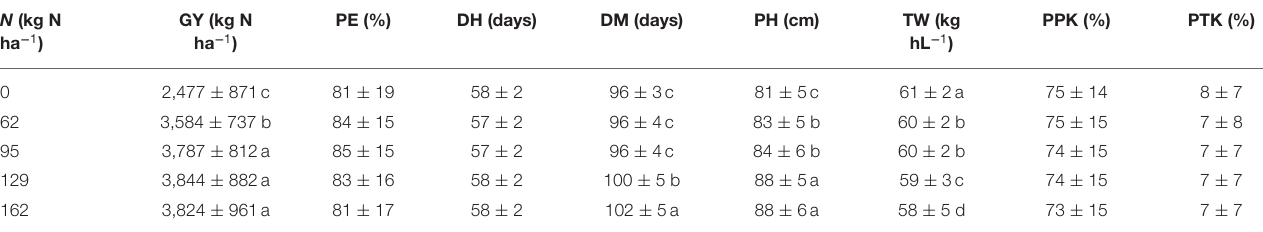
TABLE 6 | Effect of N rate on grain yield and seed quality of barley across all locations and years. N (kg N ha − 1 )